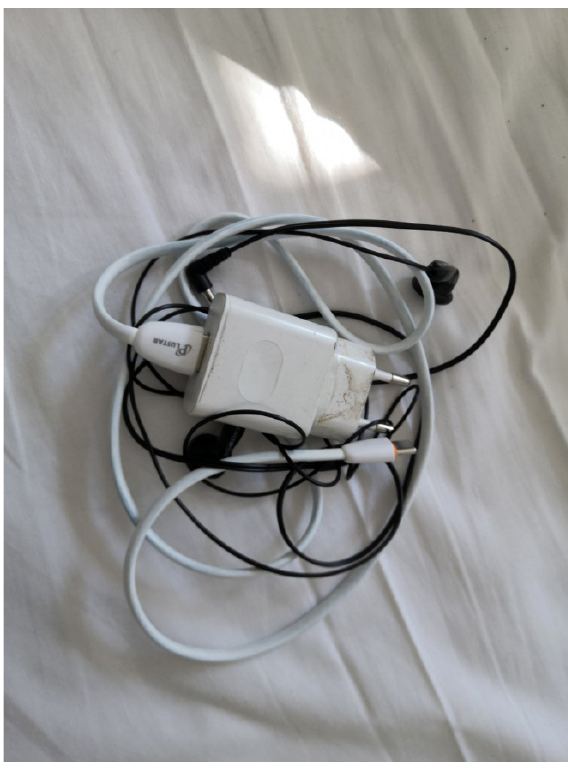
Figure 1. Small things that matter in life. The relevance of smartphone technology as an everyday infrastructure for people in precarious situations stated in earlier research (Gillespie et al., 2018; Latonero & Kift, 2018; Leurs, 2017; Ponzanesi, 2019) is also present in the outcomes of the photographic workshop. At the moment of fleeing, smartphone apps are used to trans‐ late, discover routes and border closures, discern costs, determine the best destinations, find reliable smugglers, avoid the police and the border guards, document jour‐ neys, and follow news about migration and policy in Europe. Described as a digital passage, Latonero and Kift (2018) discuss digital media as a new infrastructure of refugee